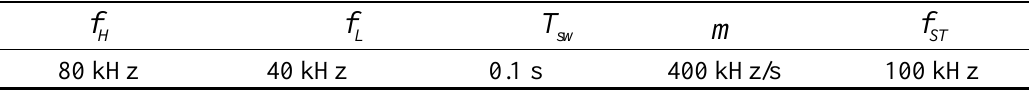
Table 1. Signal parameter setup of the experiments.